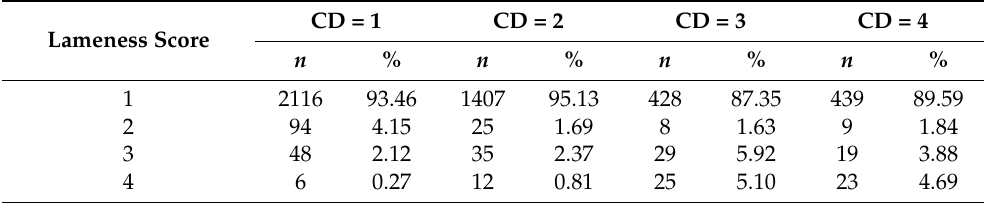
Table 2. Distribution of cows by lameness and calving difficulty.